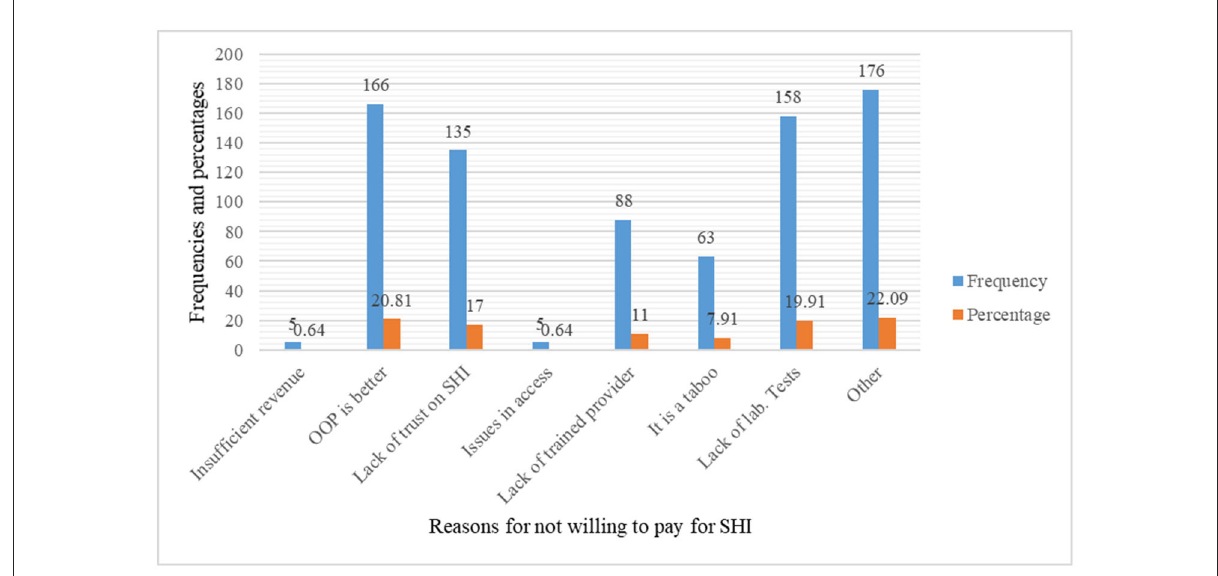
FIGURE3 The reasons for not WTP for SHI among public civil servants at DCA, North-East Ethiopia ( n = 796), May 2021.